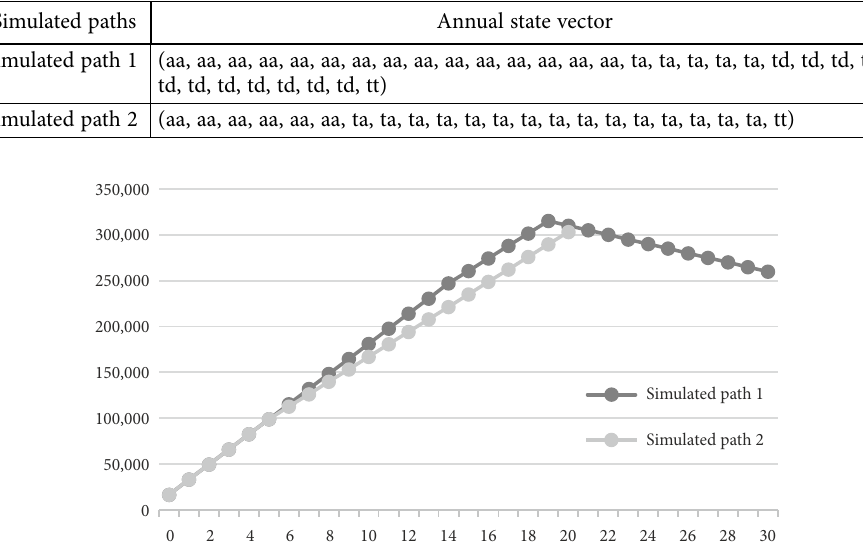
Figure 1. Simulated paths of the stochastic process S for household 8 of Profile 2 with RM (source: own